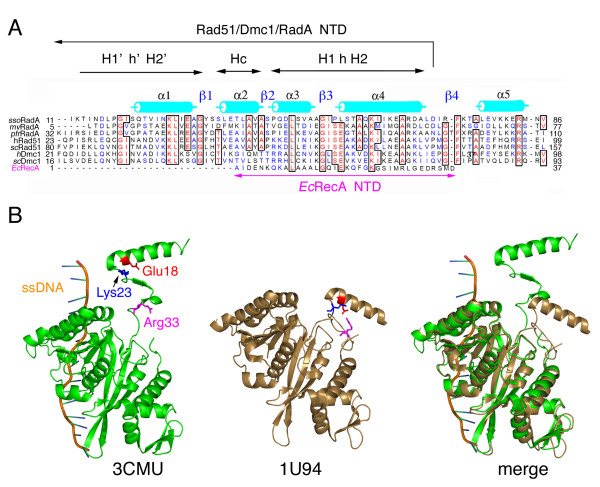
The E. coli RecA NTD exhibits significant amino acid sequence homology with the NTDs of the homologous proteins Rad51/Dmc1/RadA. (A) Sequence alignment of the NTDs of RecA proteins from S. solfataricus (SsoRadA), M. voltae (MvRadA), P. furiosus (PfRad51), H. sapiens (HsRad51 and HsDmc1), S. cerevisiae (ScDmc1 and ScRad51), and E. coli (EcRecA). Secondary structural features of the left-handed SsoRadA helical filament are indicated in cyan (α-helices)[10]. Functional motifs are indicated under their corresponding amino acid sequences: the first HhH motif (H'h'H2'), core helix (Hc the), and the second HhH motif (H1Hh2). (B) The NTD carries out a large conformational change in response to ssDNA and ATPγS. Shown are ribbon diagrams of the monomeric RecA structures in the RecA-ssDNA-ADP-AlF4- presynaptic filament [12] and in the inactive RecA protein helical filament [3]. The ssDNA and RecA polypeptides are shown in gold and green, respectively. The side chains of Glu18, Lys23, and Arg33 are depicted as ball-and-stick models.